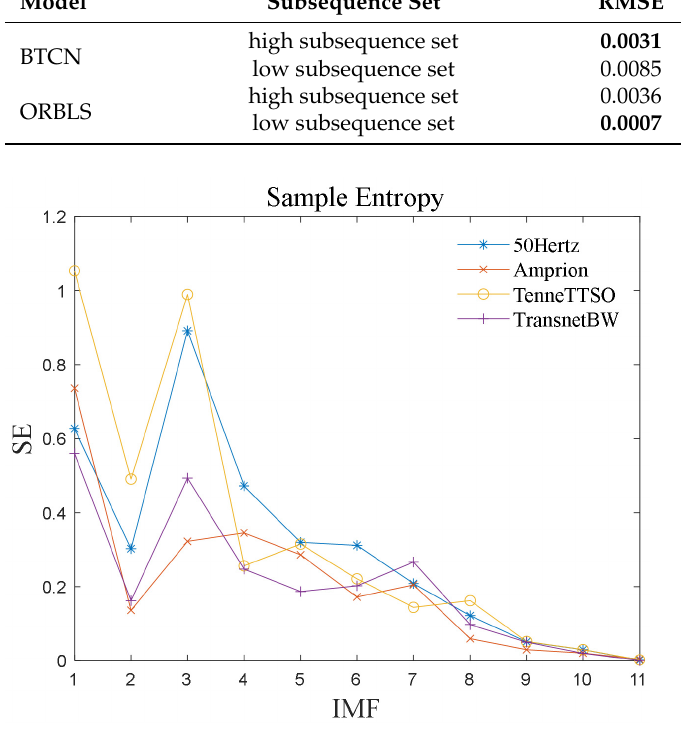
Figure 5. The value of SE for all subsequences.